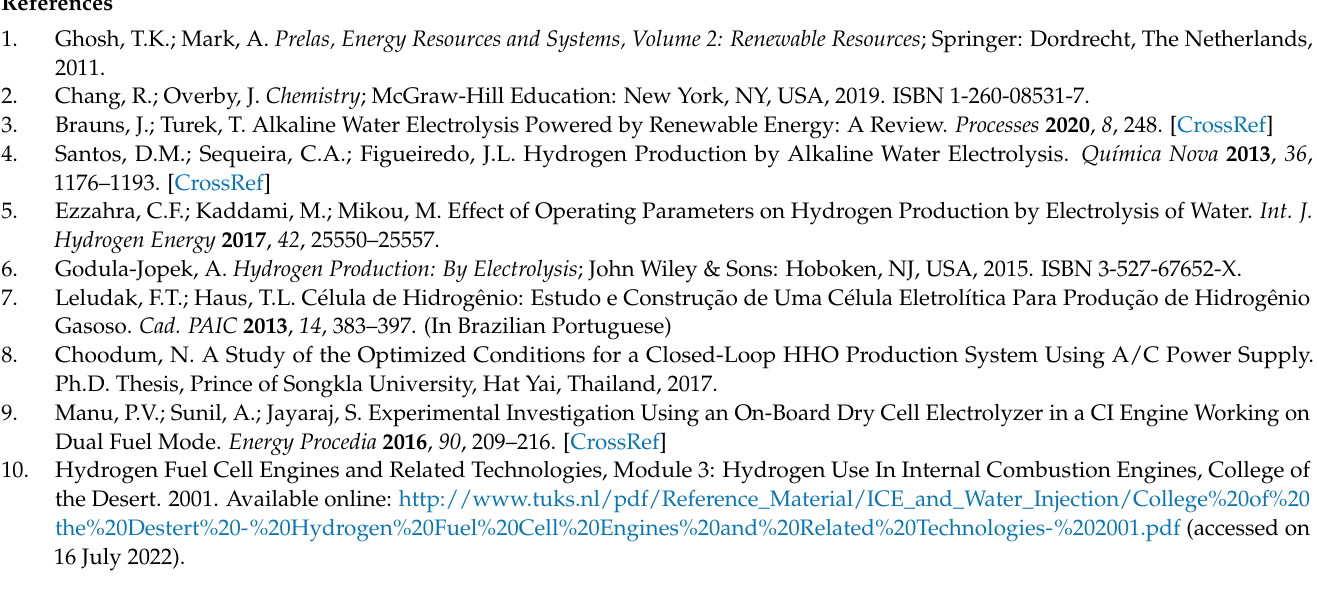
Figure A4. Flame-breaker assembly.